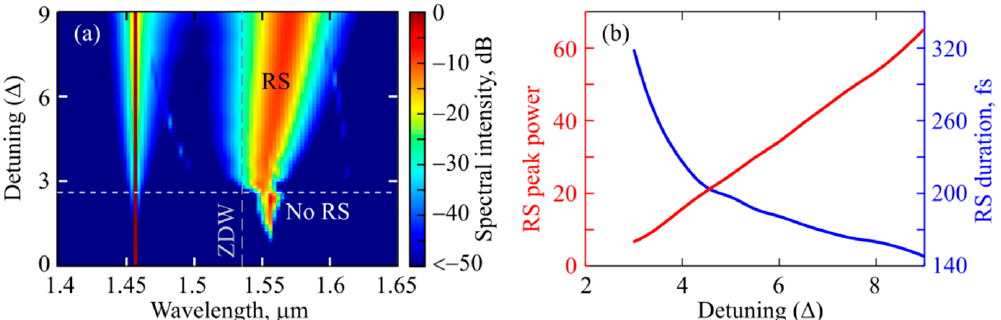
Figure 8. Numerical simulation . ( a ) Spectral intensities as a function of detuning for P = 30. Horizontal dashed line shows the threshold for Raman soliton (RS) formation. ( b ) RS peak power (red line, left axis) and RS FWHM duration (blue line, right axis) as functions of detuning.